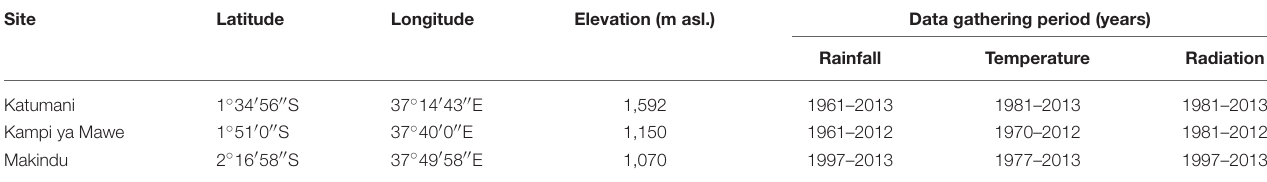
TABLE 1 | Geographical information as well as, availability of rainfall, temperature, and radiation data for the study sites in Eastern Kenya. Site Latitude Longitude Elevation (m asl.) Data gathering period